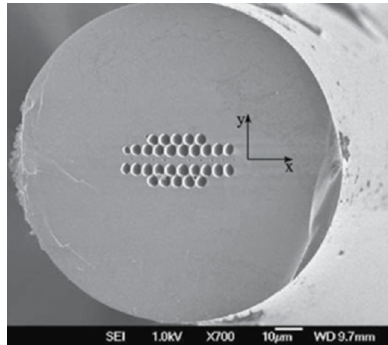
Figure 11. SEM image of the high birefringent index-guided PCF used for the measurement of polarimetric sensitivity to hydrostatic pressure (Reproduced from [57], with the permission of Springer publishing).